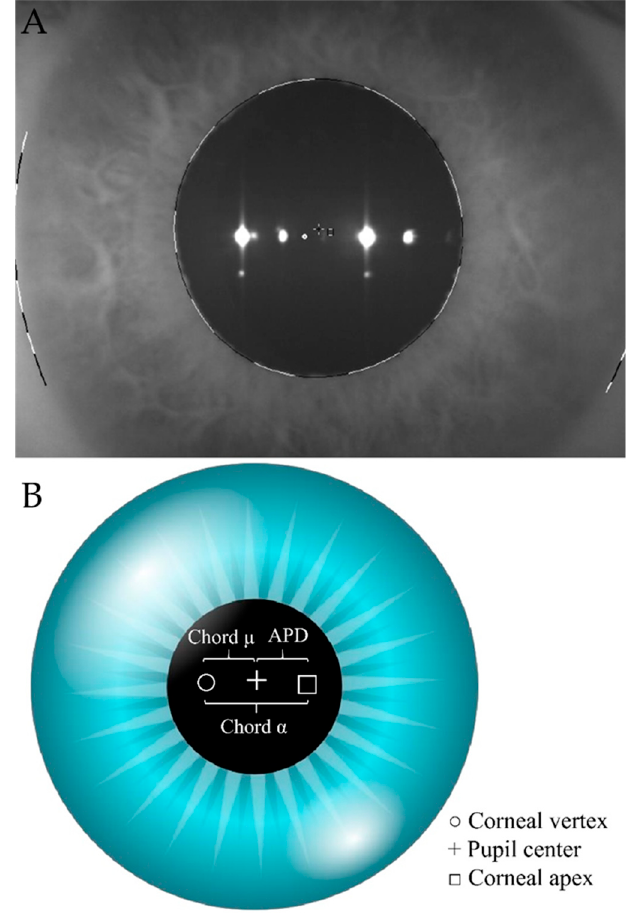
Figure 1. A —real left eye iris map from Scheimpflug Tomography (Pentacam HR; Oculus, Wetzlar, Germany). To measure chord alpha ( α ) length, we pointed to the center of the square ( □ ) which corresponded to the apex of the cornea, and we joined it to the center of the white circle ( ○ ) which corresponded to the corneal vertex. The distance in millimeters (mm.) between both points was defined as chord alpha ( α ) length. To measure APD, we joined the corneal apex ( □ ) to the center of the black cross (+) which corresponded to the center of the pupil. The distance in millimeters (mm.) between both points was defined as APD. B —simulated iris map from Scheimpflug Tomography (Pentacam HR; Oculus, Wetzlar, Germany). The white circle ( ○ ) corresponds to the corneal vertex. The black cross (+) corresponds to the center of the pupil and the square ( □ ) corresponds to the apex of the cornea. APD: Corneal apex to pupil center.